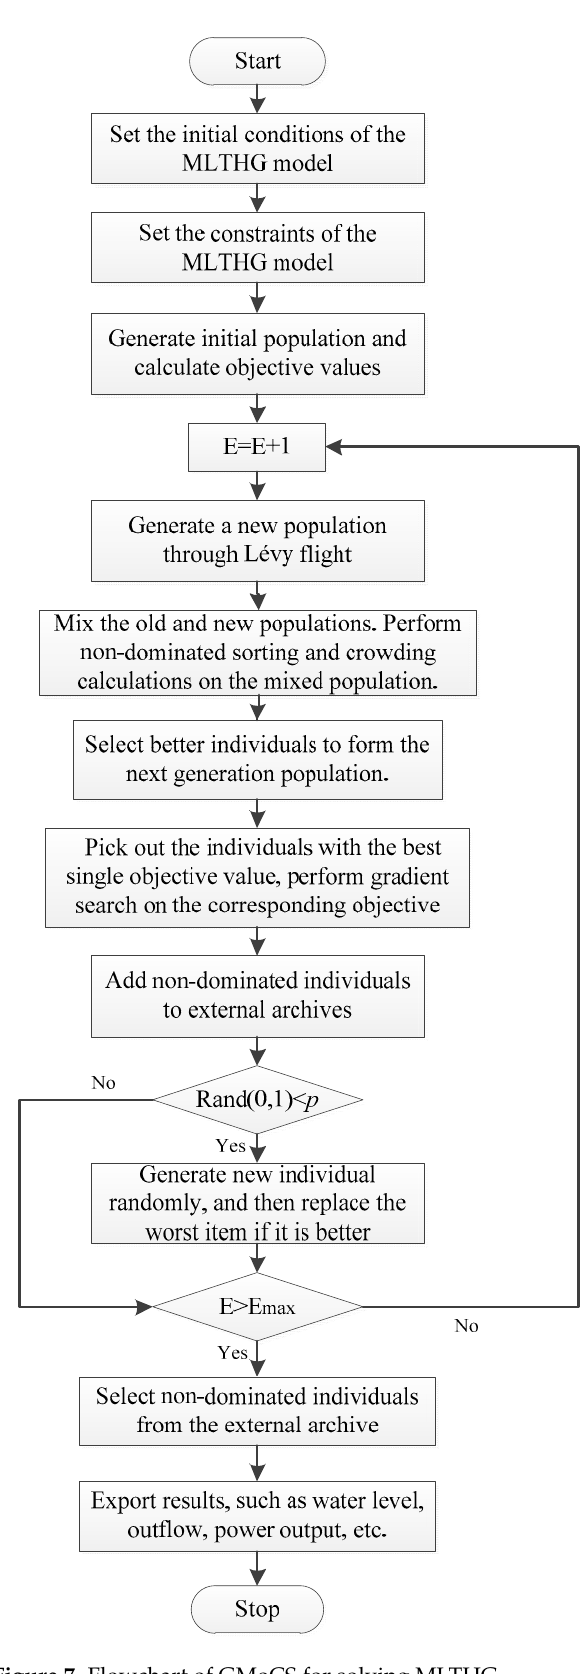
Figure 7. Flowchart of GMoCS for solving MLTHG.